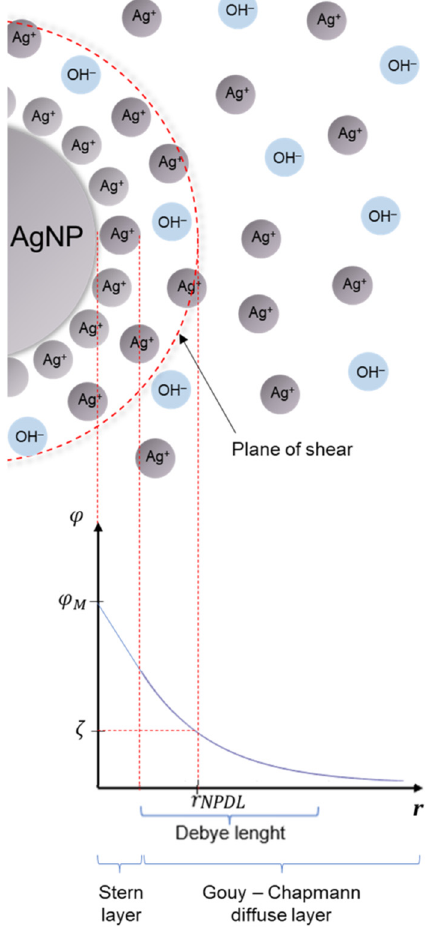
Figure 3. The model of the AgNP system and the crucial parts of the electrical double layer sur- rounding the nanoparticle. φ —electrical potential; φ M —surface potential of metallic nanoparticle; ζ —electrokinetic (zeta) potential; r NPDL —the r distance where zeta potential is measured; r —radial distance from the nanoparticle surface.